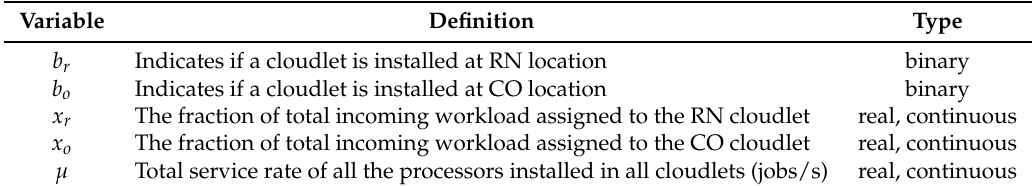
Table 2. Optimization decision